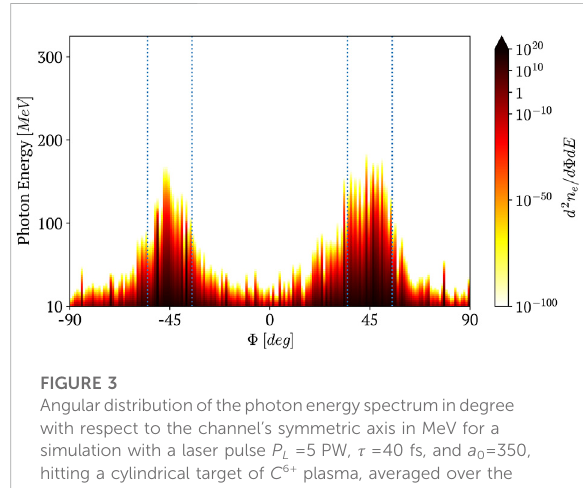
FIGURE 2 Synchrotron emission parameter η along the symmetry axis ( y =4 μ m) of the plasma channel over time for simulations of a τ =40 fs laser pulse with incident power P L =5 PW and a normalized amplitude a 0 =350. The colorbar indicates the synchrotron emission power parameter η (6), and is limited to values up to η max =0.005 (higher values are depicted as η max ) to enhance visibility.